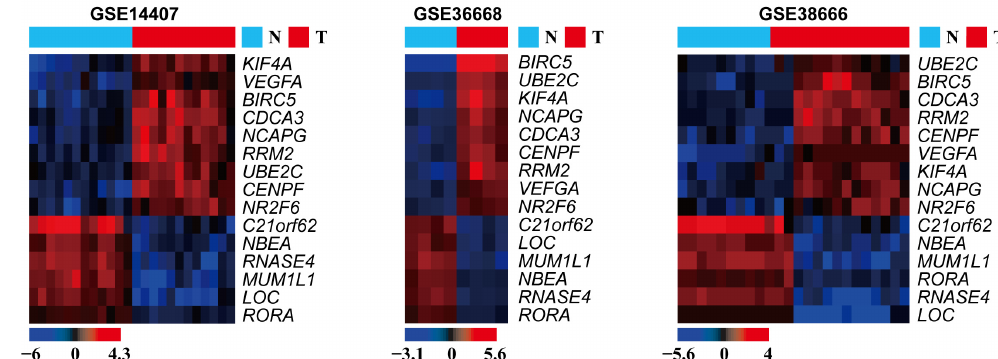
Figure 2. Heatmap showing the 15 identified DEGs in the 3 independent GEO datasets. The data are presented in matrix format, with rows representing individual genes and columns representing each tissue. Each cell in the matrix represents the relative expression level of a genetic characteristic of an individual tissue. The red and green colors in the cells reflect relatively high and low expression levels, respectively, as indicated by the scale bar. N: normal; T: tumor; LOC: